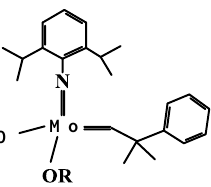
Figure 1. Typical Schrock carbenes.